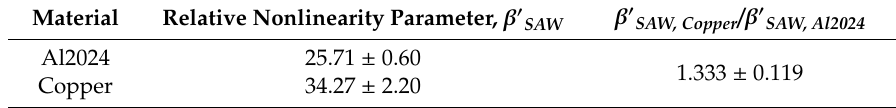
Table 1. Measurement values for the relative nonlinearity parameter of Al2024 and copper. Material Relative Nonlinearity Parameter, β′ SAW